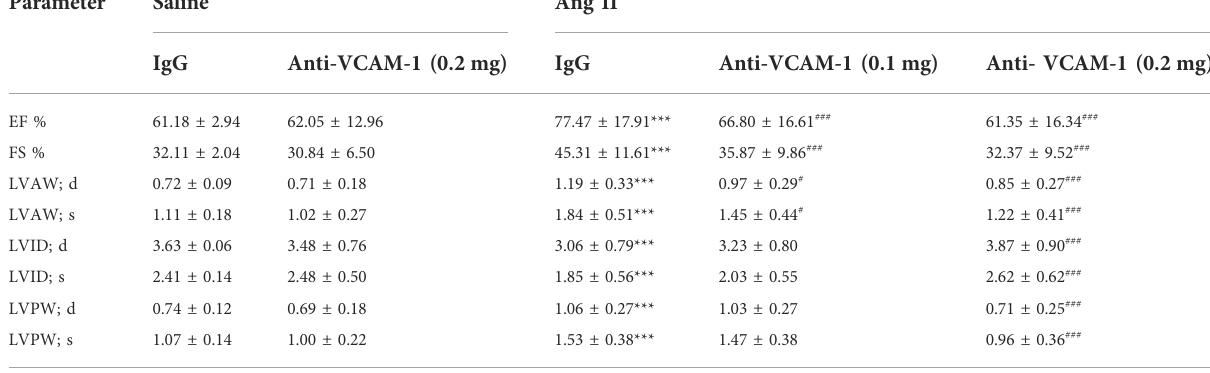
TABLE 3 Echocardiographic parameters of WT mice treated with Anti-VCAM-1 antibody or IgG control after Ang II infusion.